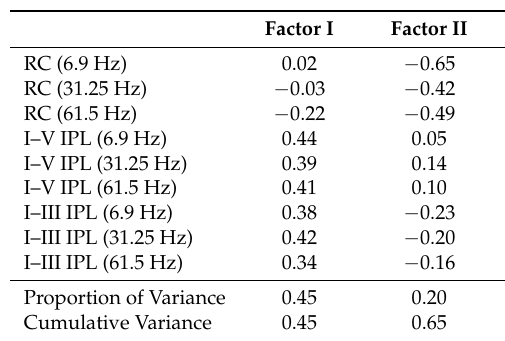
Table 7. PCA of ABR Indices. The factors and factor loadings of the PCA computed over indices of sensorineural auditory processing derived from the averaged auditory brainstem response (ABR). The PCA yielded two factors that explained 65% of the cumulative variance in ABR indices. Factor 1 had stronger loadings for the inter-peak latency measures (IPLs), suggesting that this factor largely reflected subcortical neural conduction times. Factor 2 had stronger loadings for the response consistency (RC) measures, suggesting that this factor largely reflected the response consistency of the ABR over a single recording session.